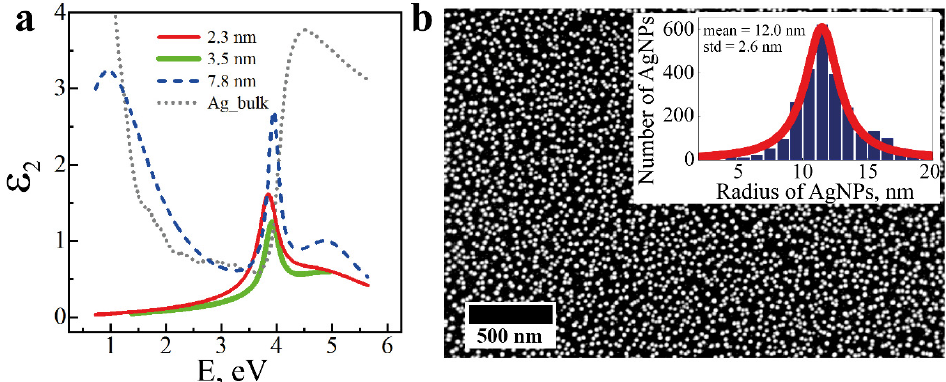
Figure 2. ( a ) Spectral dependences of the imaginary part of the complex dielectric function ε 2 defined within the framework of the Drude–Lorentz model, depending on the energy for three obtained layers of AgNPs with d Ag from 2.3 to 7.8 nm; ( b ) SEM image of the deposited AgNP layer with thickness d Ag = 7.8 nm on the Si wafer surface; the inset shows a distribution histogram of AgNPs depending on their radius, where the red line is the Gaussian distribution.